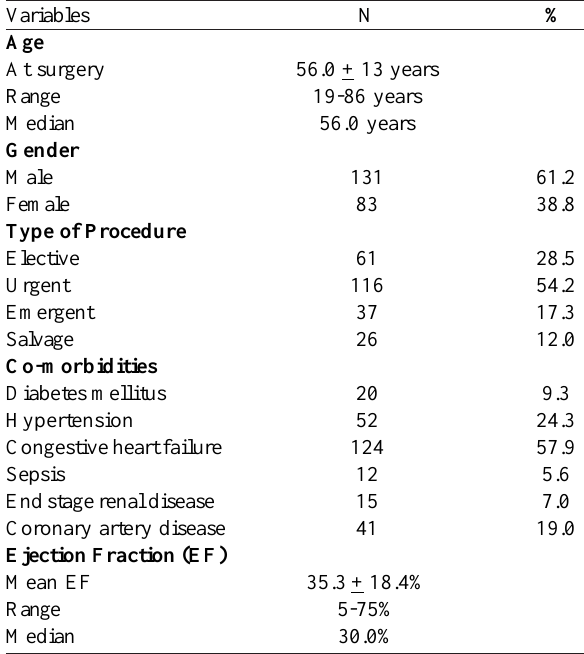
Table 1. Patients’ Clinical Characteristics